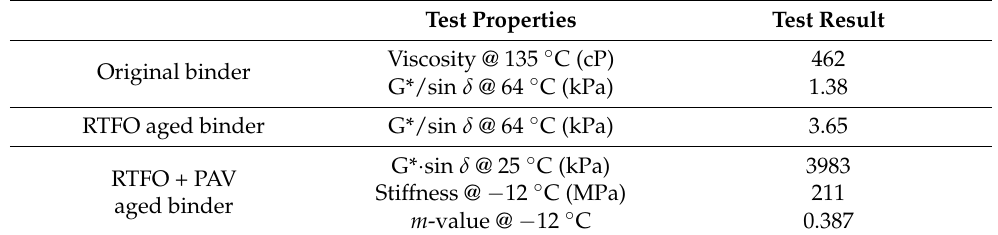
Table 1. Properties of base asphalt binder (PG 64-22). Table 2. Properties of base oil.